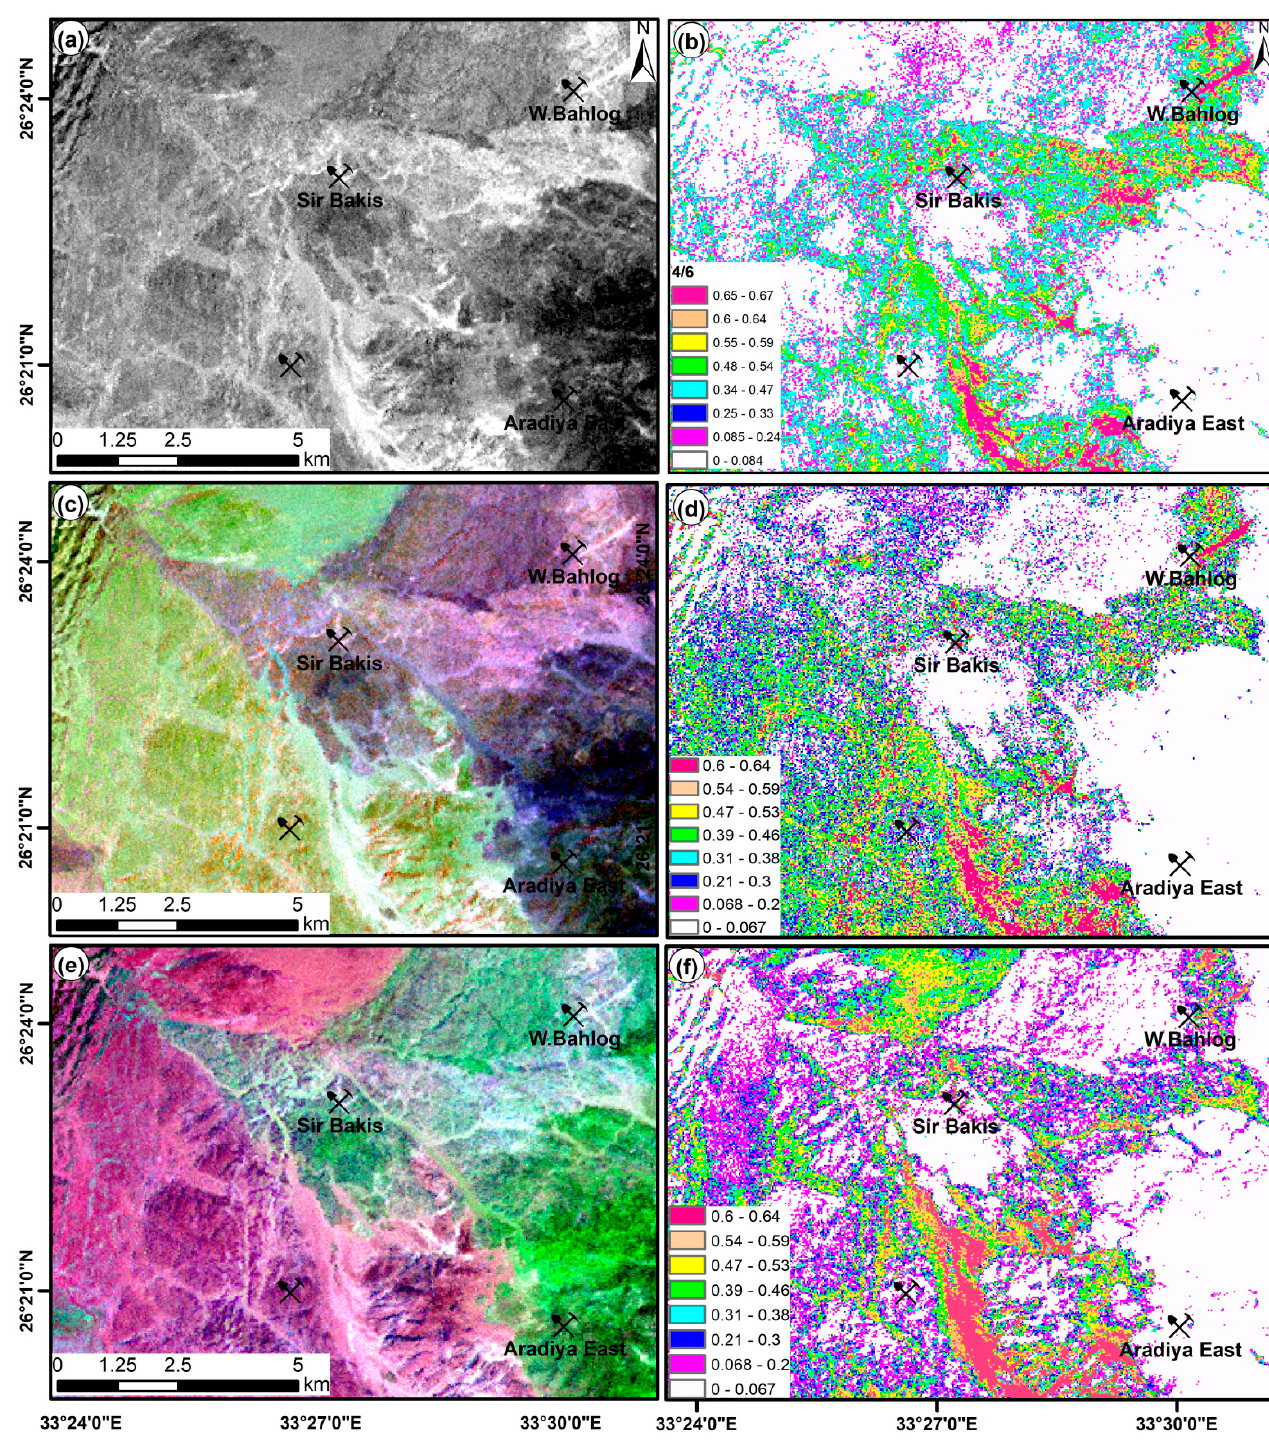
Figure 5. ( a ) Band ratio 4/6 of ASTER data; ( b ) extracted GIS map showing areas of sericitic+argillic hydrothermal alteration derived from band ratio 4/6; ( c ) OH-I, KAI, and (B4 × 3)/(B5 + B6 + B7) of ASTER data showing areas of hydrothermal alteration in white; ( d ) extracted GIS map showing areas of Al-OH-bearing minerals in red; ( e ) image of band ratios 4/5, 4/7, and 4/6 of ASTER; ( f ) extracted GIS map of band ratios 4/5, 4/7, and 4/6 showing hydrothermal alteration zones in red.